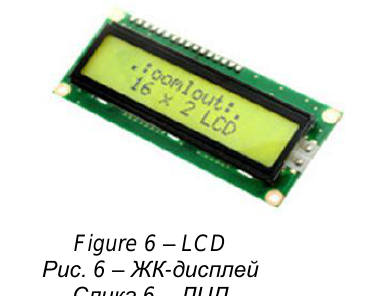
Figure 6 – LCD Рис. 6 – ЖК-дисплей Слика 6 –